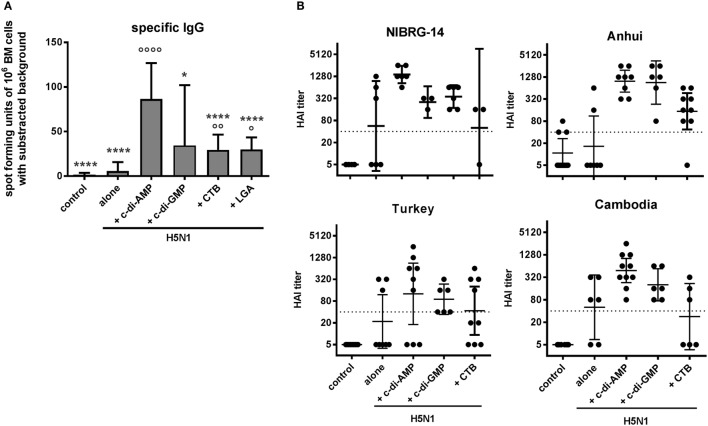
Memory and cross-reactivity. Groups of five BALB/c mice were immunized i.n. with PBS (control) or with two doses (21 days apart) of H5N1 virosomes (7.5 µg hemagglutinin HA), alone or adjuvanted with cyclic di-adenosine monophosphate (c-di-AMP) (5 µg), c-di-GMP (5 µg), cholera toxin subunit B (CTB) (10 µg), or last (or third) generation adjuvant (LGA) (7.5 µg). (A) Immunological memory. Two to three weeks after the second immunization, bone marrow (BM) cells were harvested, pooled, and restimulated with homologous H5N1 virosomes. The number of antigen-specific IgG-producing B cells derived from the BM was determined by ELISpot. Results are presented as antigen-specific spot-forming units of 106 restimulated cells minus the background unstimulated values. The mean + SD is shown from quadruplicates in two cell concentrations of n = 3 (PBS, alone, CTB) or n = 2 (c-di-AMP, c-di-GMP, and LGA) independent experiments. Statistically significant differences were measured by one-way ANOVA with Tukey’s post hoc test; differences from the c-di-AMP or antigen alone group are shown by asterisks or circles, respectively (*/°p < 0.05, **/°°p < 0.01, ***/°°°p < 0.001, ****/°°°°p < 0.0001). (B) Cross-clade reactivity. Two to three weeks after the second immunization, blood was sampled and sera obtained. The HAI titers against the homologous vaccine strain and genetically distinct (clade) strains were measured and are presented as one symbol per animal. The lines represent the geometric mean of the titers with 95% CI; the dotted line shows the protective HAI titer of 40. Negative samples were assigned a value of 5 for calculation purposes. One experiment out of three independent experiments is shown.